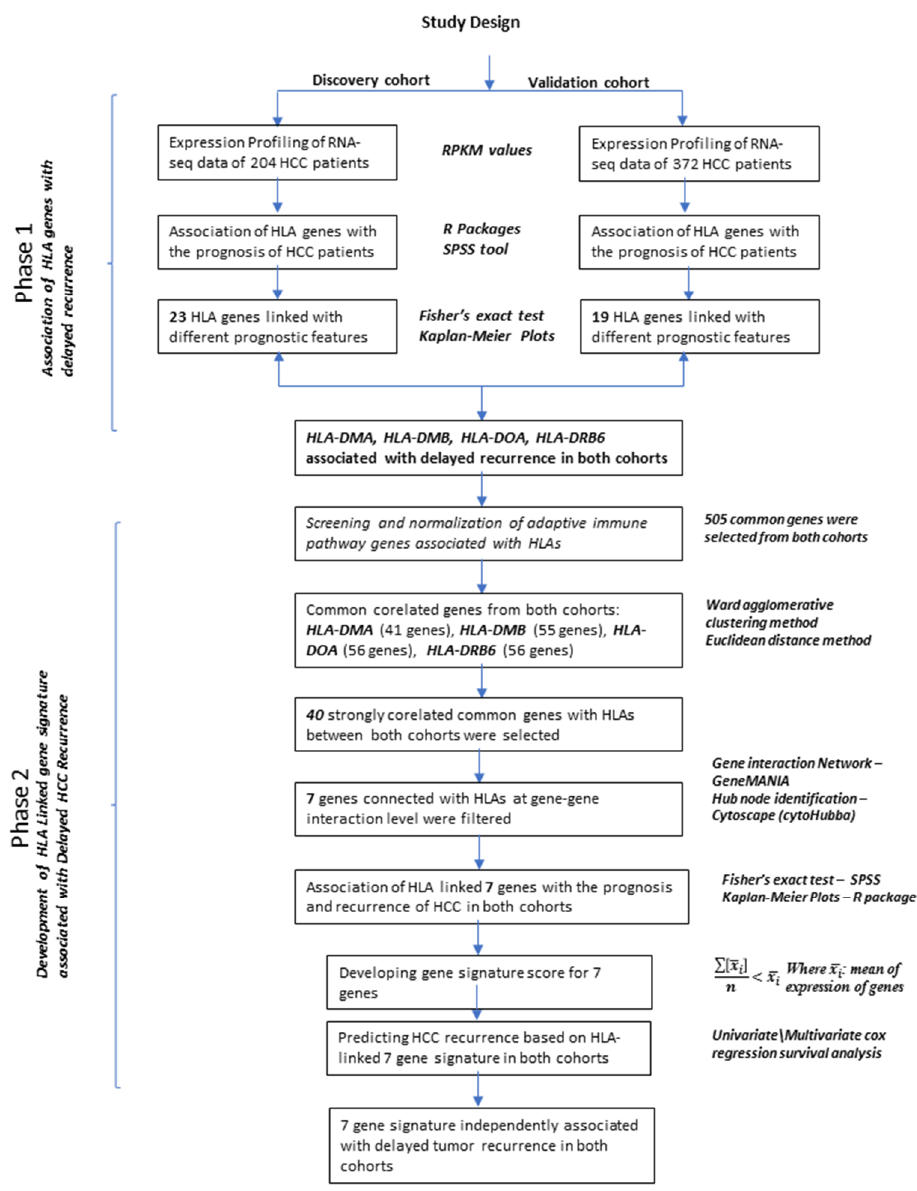
Figure 1. A detailed workflow of the study.